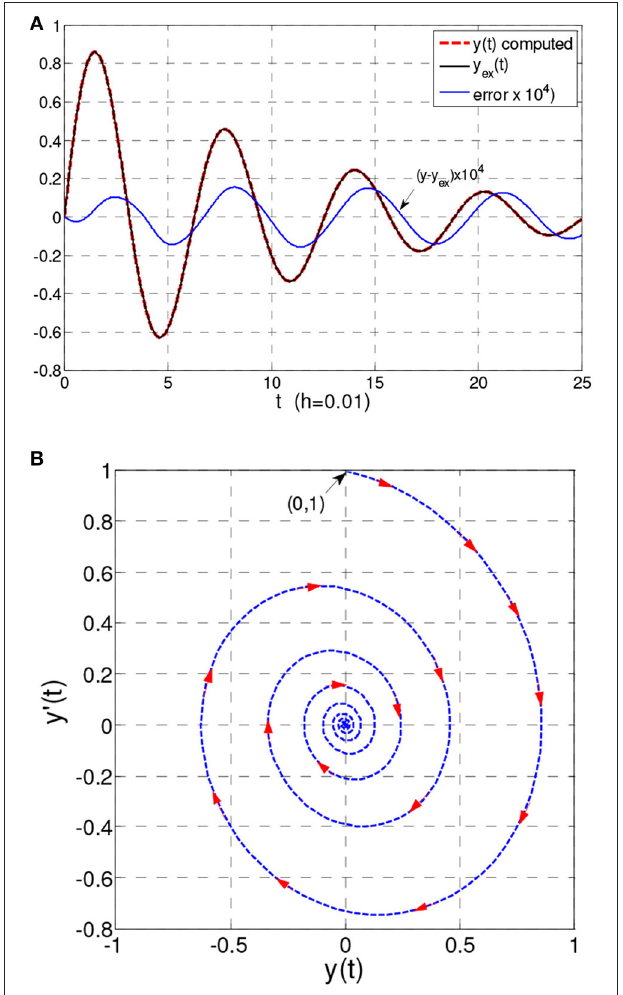
y ex in Example 7. (B) Phase plane −